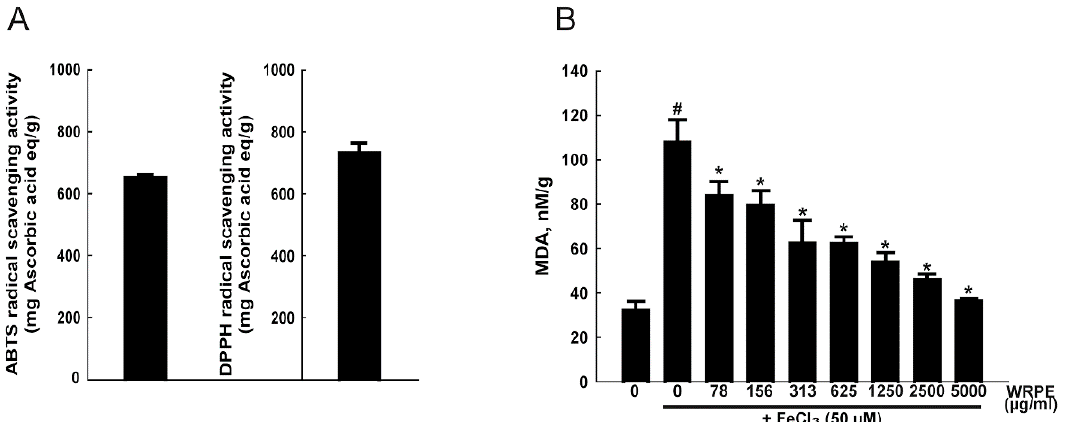
Figure 2. Antioxidant activities of white rose petal extract (WRPE). ( A ) 2,2 ′ -azino-bis-3-ethylbenzthiazoline-6-sulphonic acid (ABTS) radical-scavenging activity (ascorbic acid equivalent/g extract) for 60 min. 1,1-diphenyl-2-picrylhydrazyl (DPPH) radical-scavenging activity (ascorbic acid equivalent/g extract) in 30 min. ( B ) Inhibitory activity on FeCl 3 -induced lipid peroxidation (TBARS production). n = 5 per treatment group. # Significantly different from normal control ( p < 0.05). * Significantly different from vehicle control ( p < 0.05).